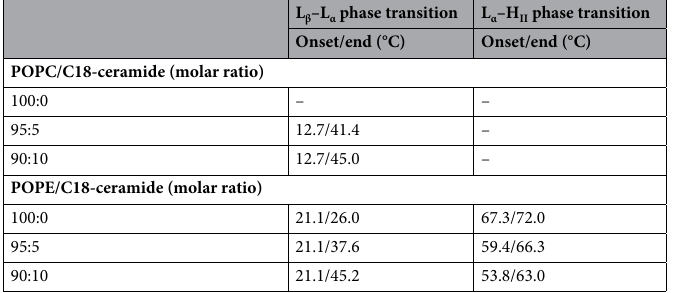
Table 1. The L β –L α and L α -H II phase transition temperatures of POPC/C18-ceramide dispersions and POPE/ C18-ceramide dispersions.